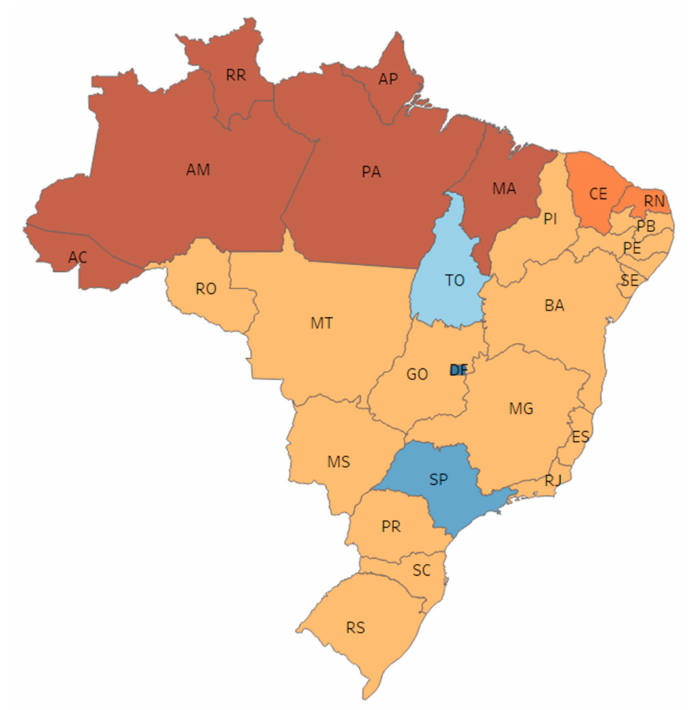
Figure 4. Map of Brazil generated from the dendrogram result with six clusters (with all age groups). Two large clusters contain 80% of the Brazilian states, presenting a great homogeneity in the behavior of the